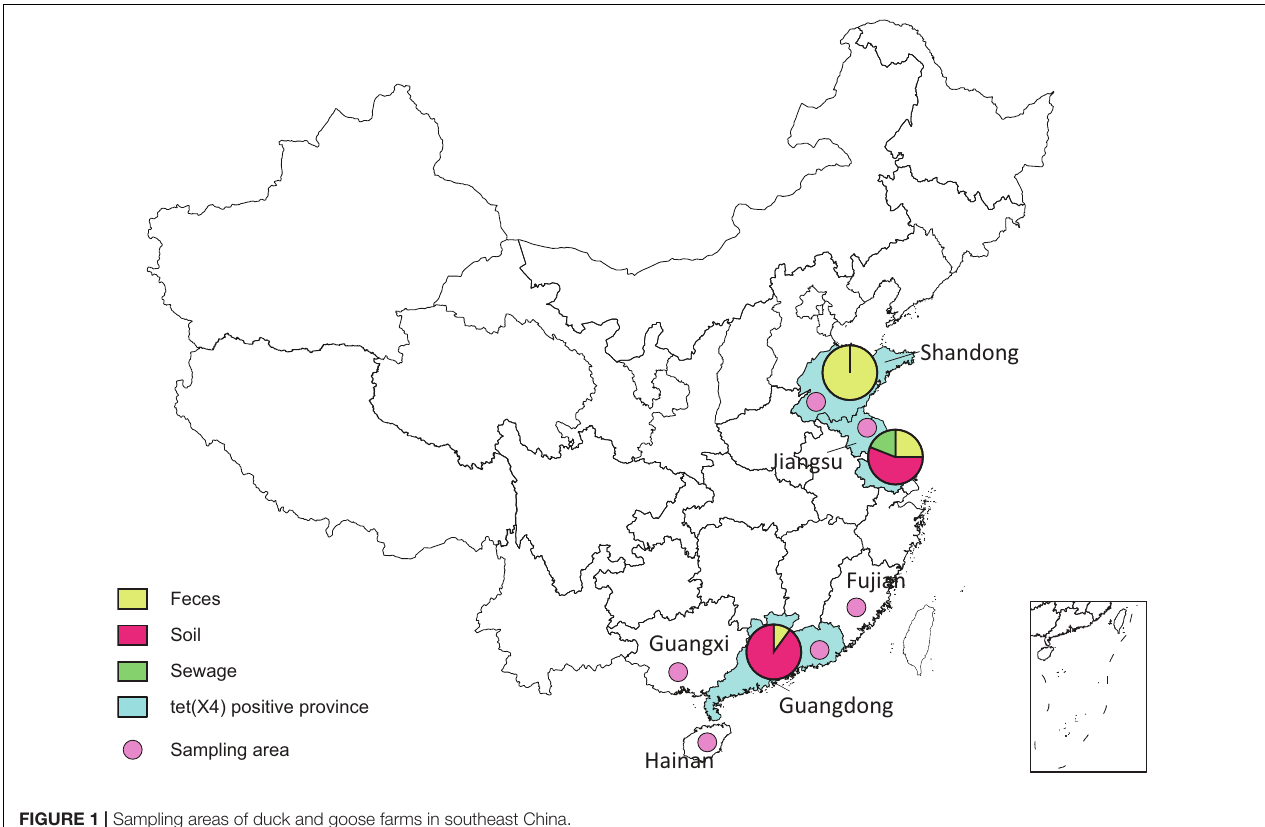
FIGURE 1 | Sampling areas of duck and goose farms in southeast China.